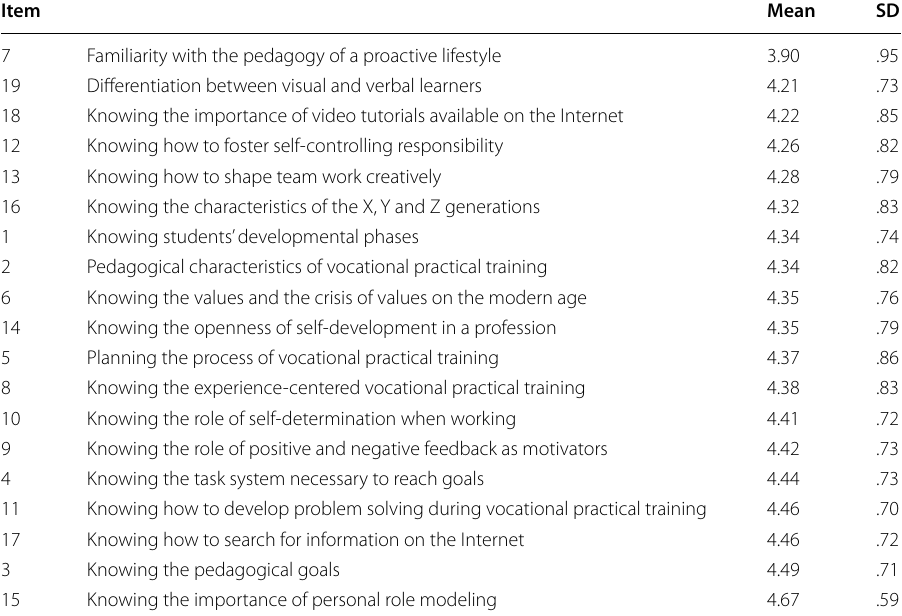
Table 3 Importance of different pedagogical knowledge items as ascertained by voca- tional education